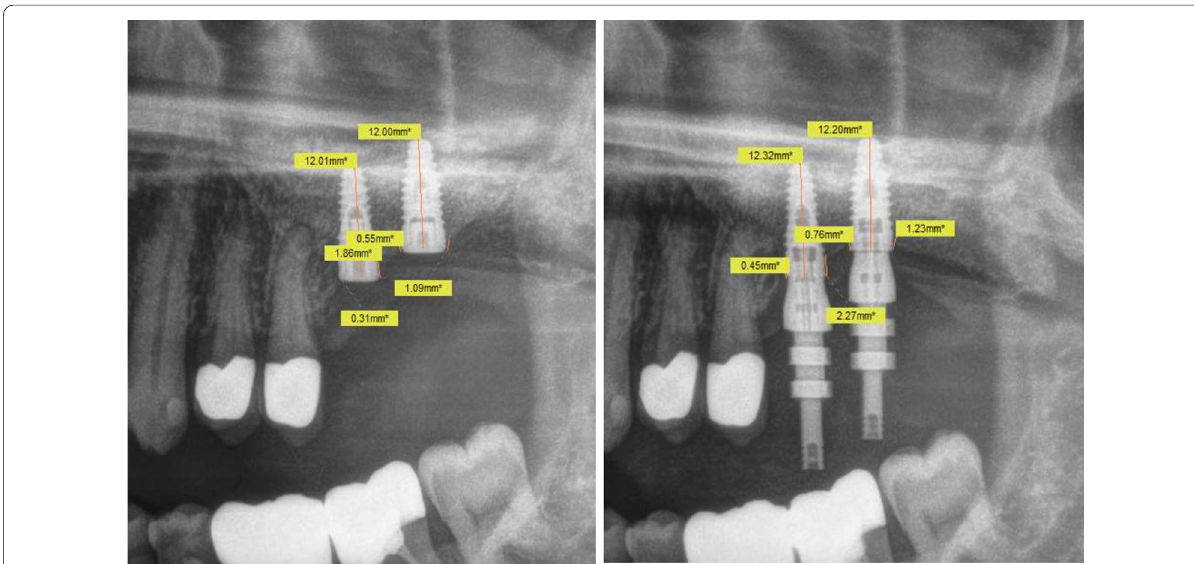
Fig. 3 Analysis of radiographs using the measuring tool (Sidexis 4, Dentsply Sirona, York, USA) taken at the time of implantation (left) and after 6 months (right). The measuring tool was used to calculate distances between implant shoulder and marginal bone mesially and distally of the